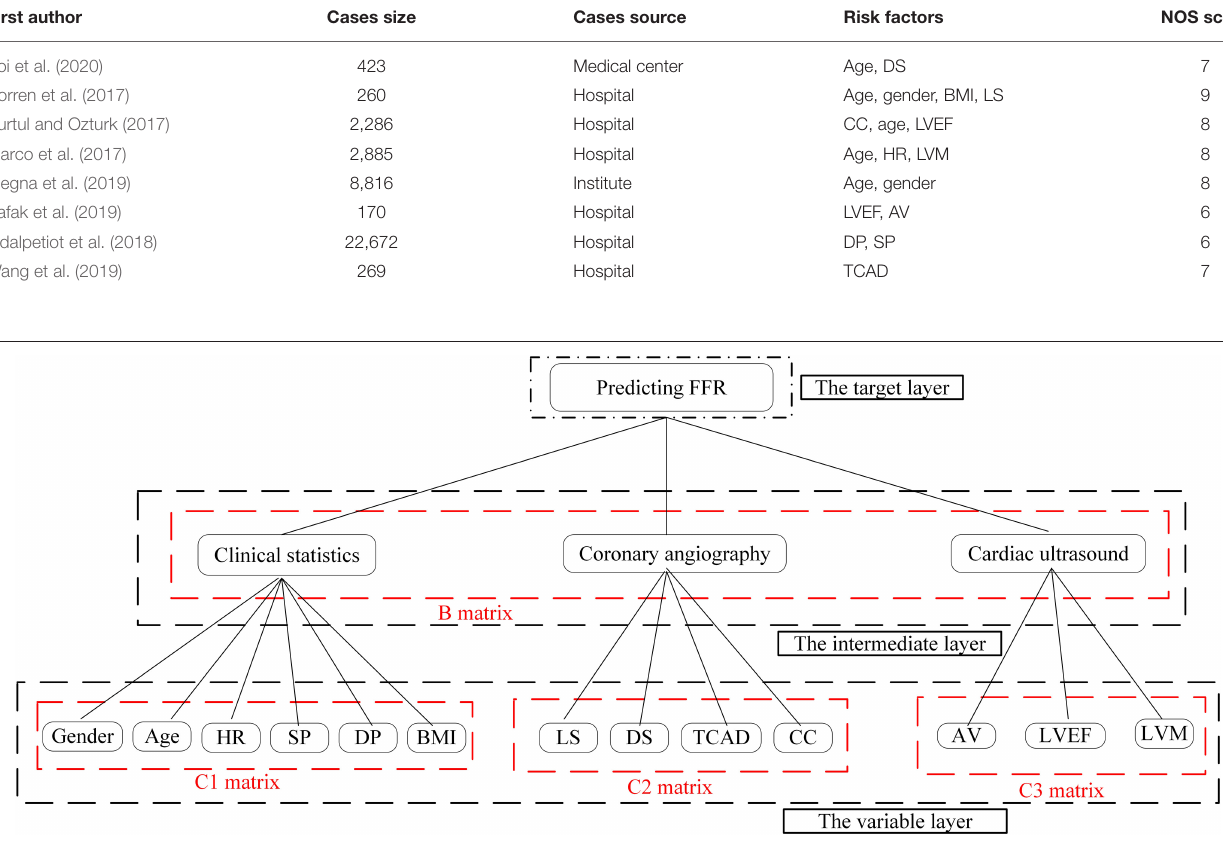
FIGURE 1 | Hierarchical structure about the predicting fractional flow reserve